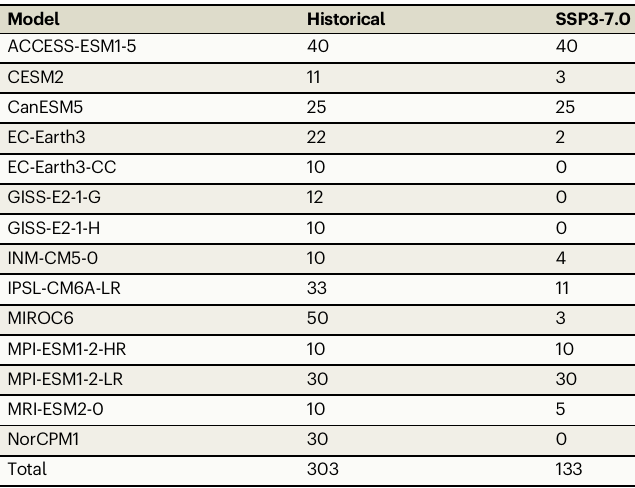
Table 1 | Number of historical runs, and future runs of CMIP6 models analyzed in this